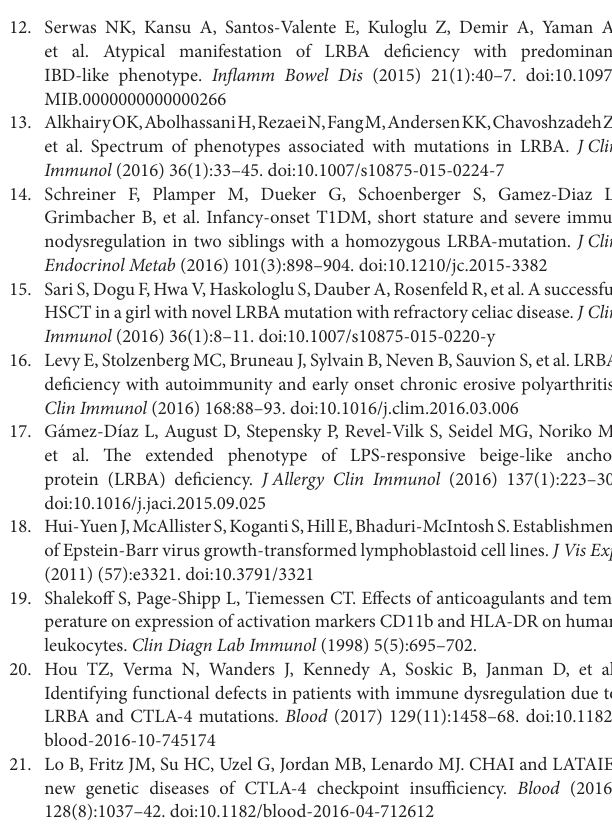
(left). (B) EBV cells from healthy donor (blue) treated with LRBA-blocking peptide (Atlas Antibodies, cat. no. APrEST74668) using different ratios of peptide: LRBA antibody. FIGURe s2 | Time course of LRBA protein expression in total peripheral blood mononuclear cells (PBMCs) using different stimuli. Statistical analysis was performed comparing 0 h with 16, 24, 48 h, or 4 days after stimulation. All stimulation conditions and time points were performed in three samples independently. FIGURe s3 | Peripheral blood mononuclear cells (PBMCs) need stimulation to promote LRBA expression. LRBA expression was detected by flow cytometry in fresh PBMCs from seven different healthy donors without stimulation (white squares) and upon stimulation with phytohaemagglutinin (PHA) (10 ng/µl) for